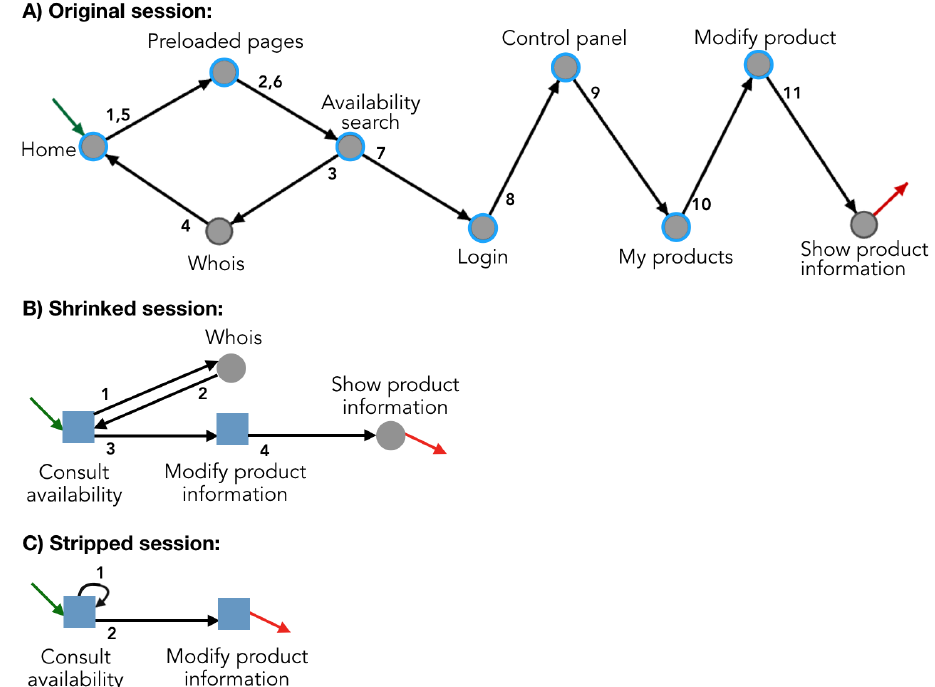
Figure 4. Example of a session represented with rules. ( A ) shows the original session. The green (respectively, red) arrow indicates the entry (respectively, exit) page. Circles with a blue border are pages that are part of a rule. This session belongs to visitors from the class “Other conversions”. Therefore, we only used the rules identified in that class of visitors. We obtained ( B ) by representing the session with rules. ( C ) is the result of removing all pages that do not form a rule. Table 6. Statistics of the length of sessions represented as rules. Metrics in rows 1 to 3 refer to the length of sessions in each representation. Metrics in rows 4 and 5 refer to the reduction rate with respect to the original session. In the last row, we indicate the percentage of sessions that we used in calculations. A total of 30% of sessions do not include any rule. Thus, in the last column, the percentage is reduced to